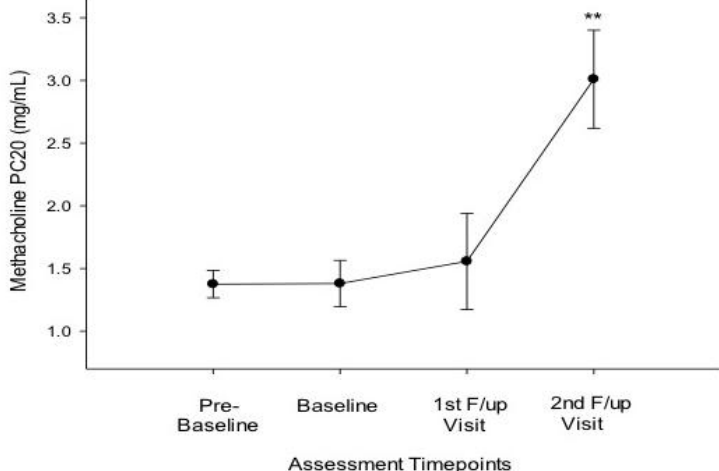
Figure 3. Methacholine PC20 at the four timepoints of